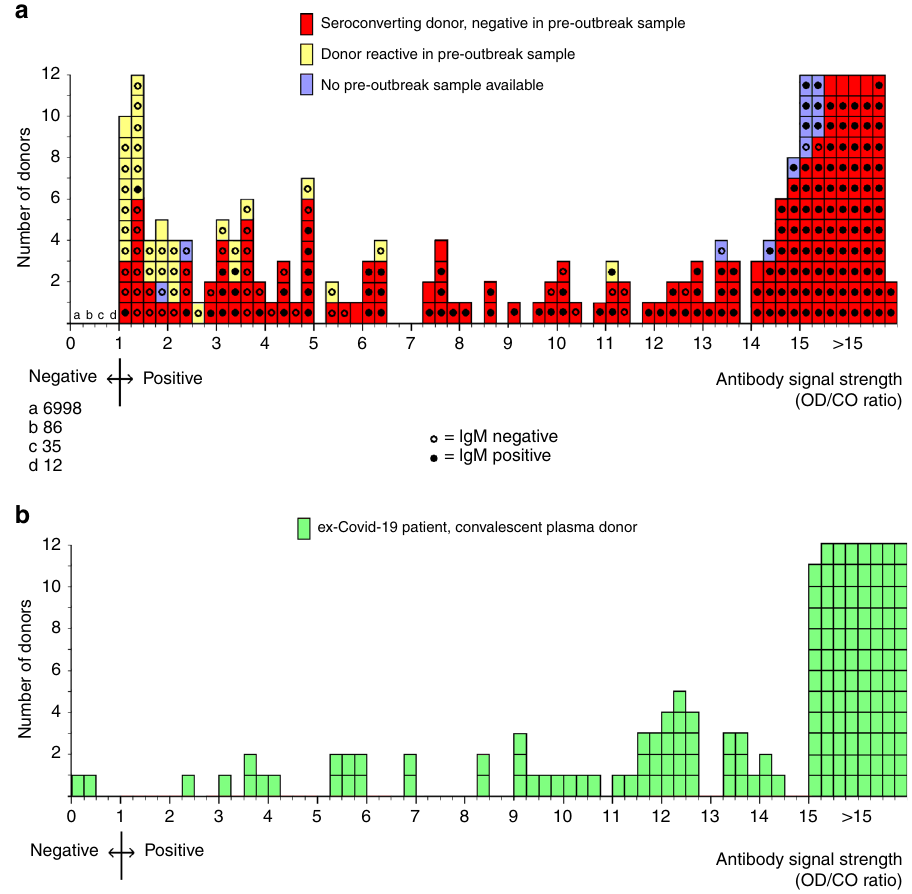
Fig. 1 Distribution of SARS-CoV-2 antibody signals in regular blood plasma donors and in recovered COVID-19 patients donating convalescent plasma; 1 – 15 April 2020. a Distribution of SARS-CoV-2 total antibody signals and SARS-CoV-2 IgM test results in regular blood plasma donors ( n = 7,361). b Distribution of SARS-CoV-2 total antibody signals in recovered COVID-19 patients donating convalescent plasma ( n =